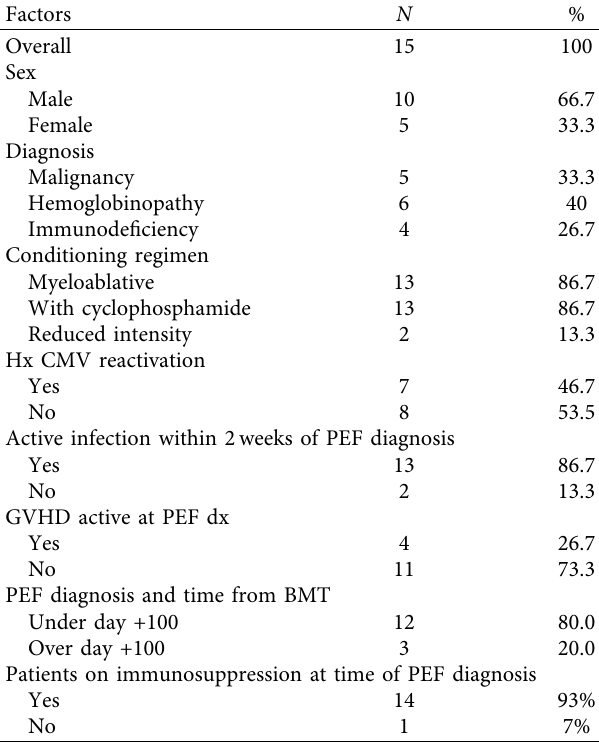
Table 1: Characteristics of patients developing pericardial